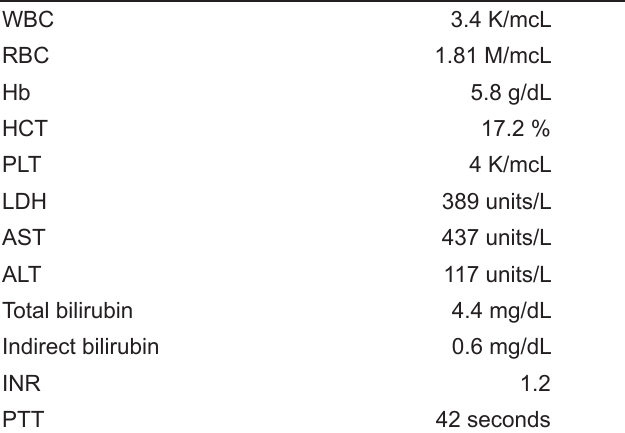
Table. Laboratory results relevant for Evans syndrome in the emergency